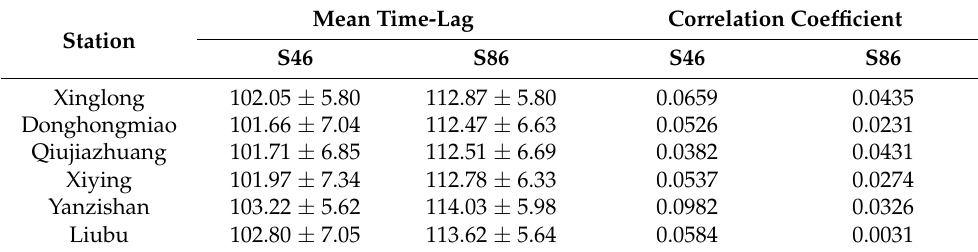
Table 4. Time-lag and Correlation coefficient of groundwater level and precipitation. Mean Time-Lag Correlation Coefficient Station S46 S86 S46